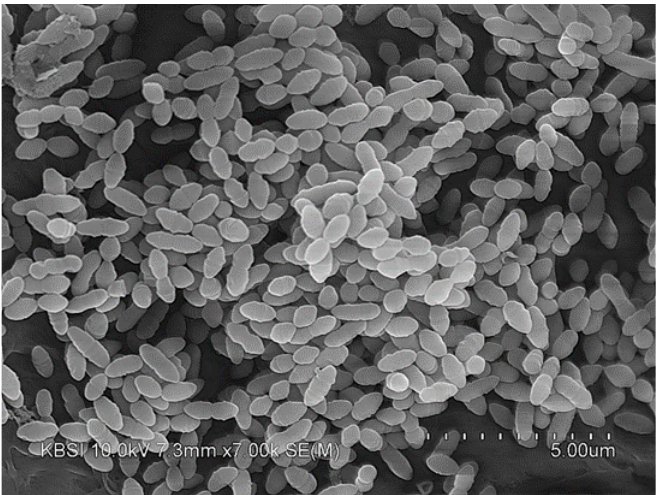
Figure 7. SEM photograph of the isolated Cicaria